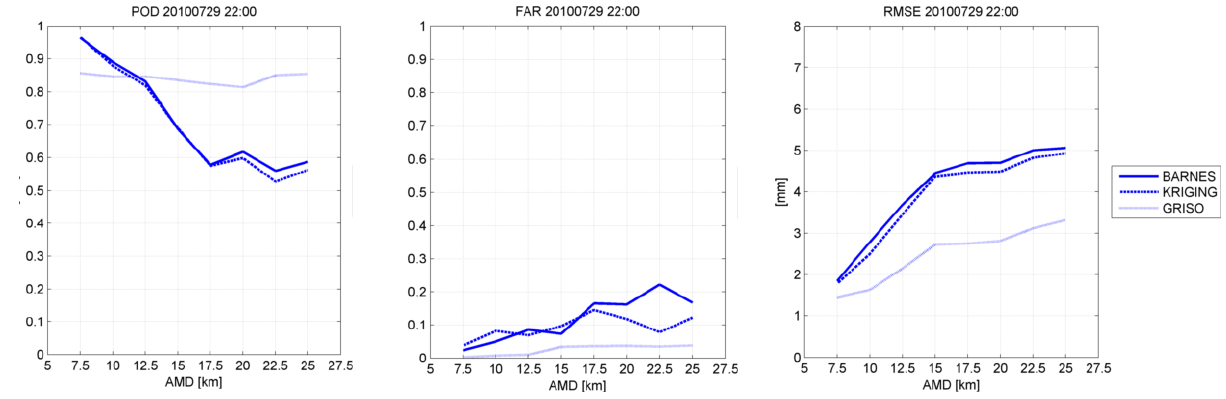
Fig. 3. Comparison between statistical scores of the ability to reconstruct the original rain gauge measurement field for the different interpolation techniques: Barnes, Kriging and GRISO. Scores presented here are: POD (left), FAR (centre), and RMSE (right).